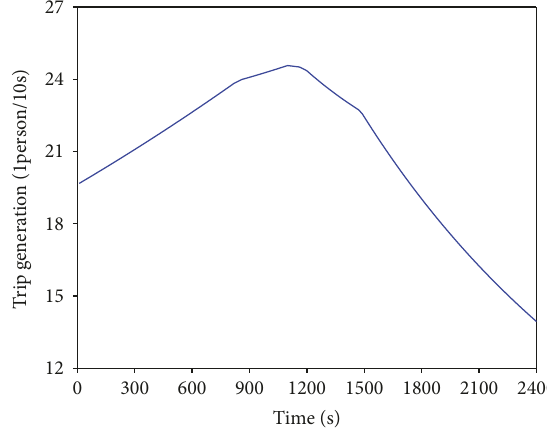
Figure 7: The overall trend of trip